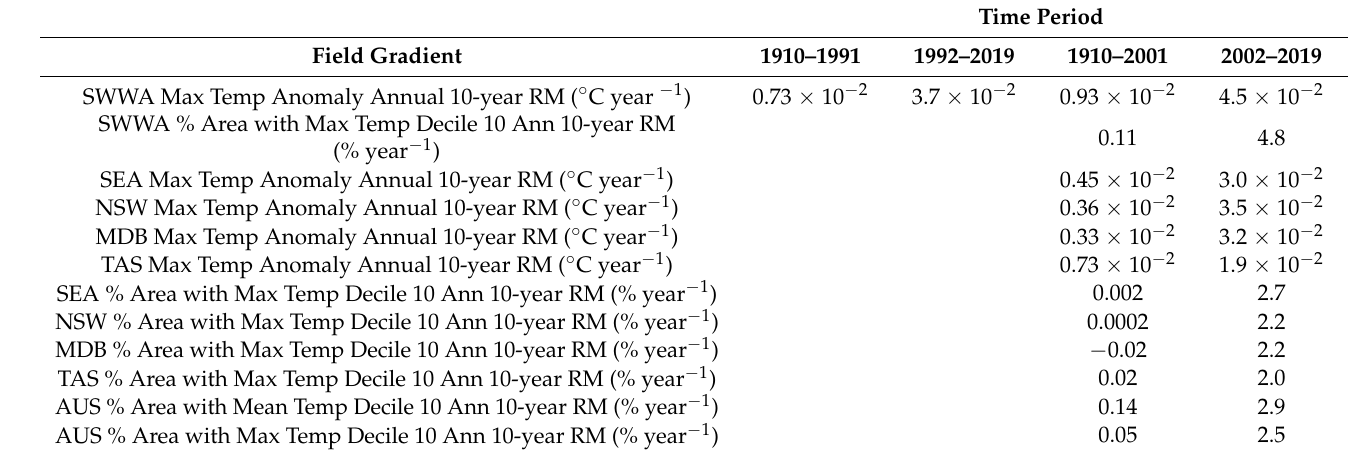
Table 10. As in Table 9 for the gradients or trends of 10-year RM of the temperatures and PAT D10 .